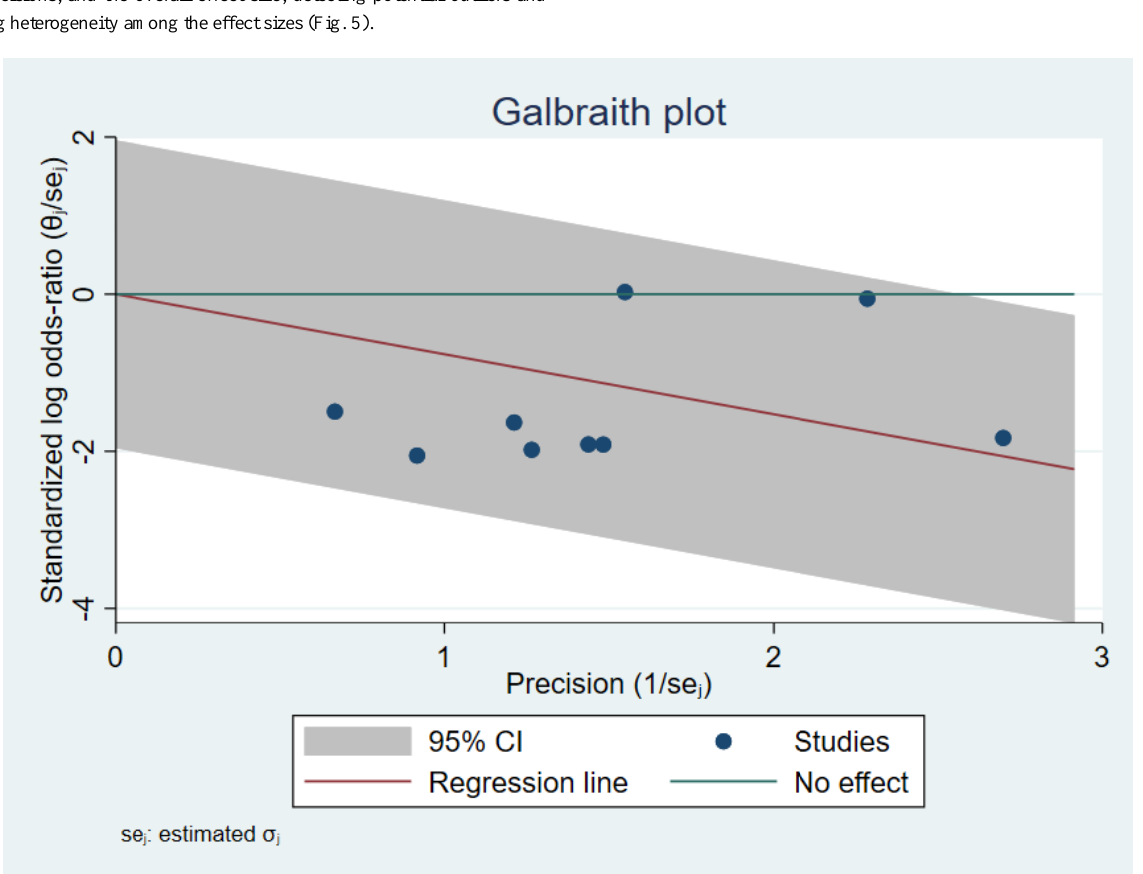
Fig. 5. Galbraith